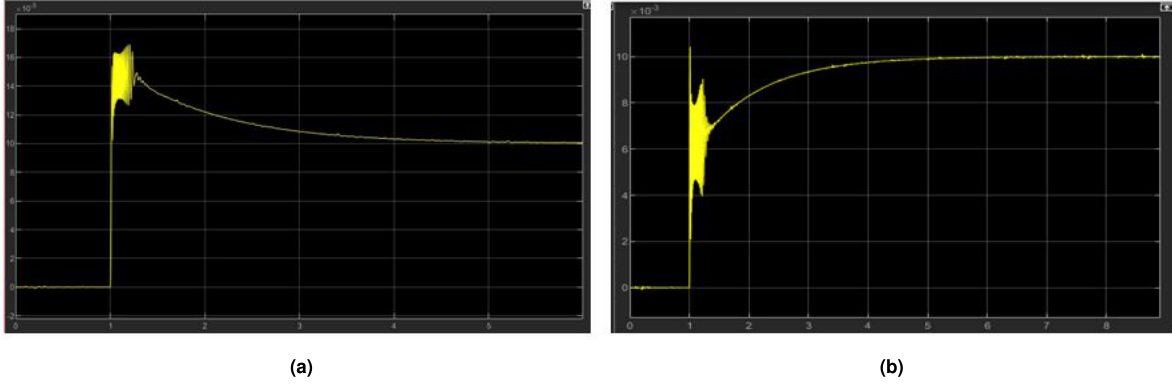
Fig. 6. (a) Drone movement output-1 model from MATLAB SIMULINK. (b) Drone movement output-2 model from MATLAB